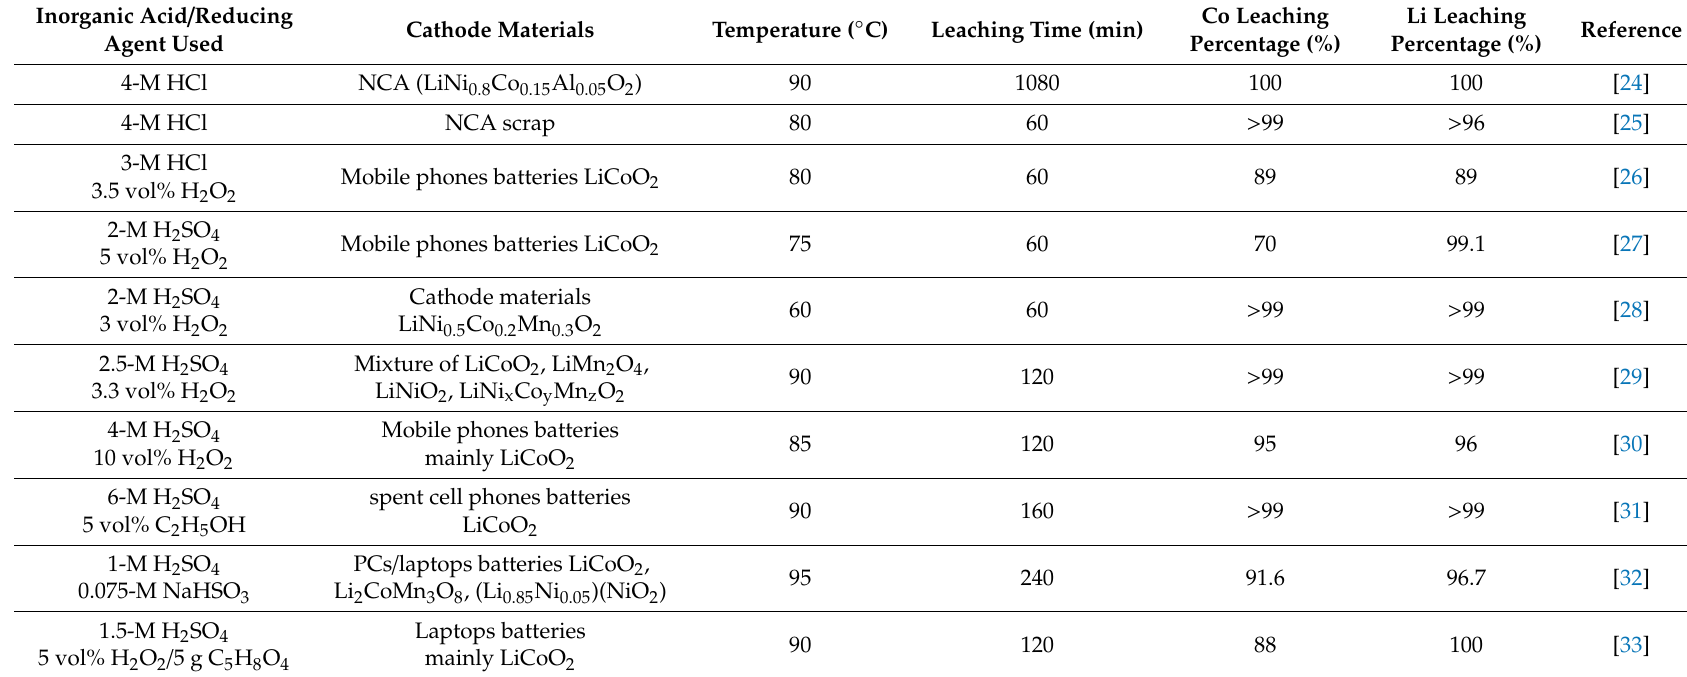
Table 2. Recent research for cathodic metals leaching by inorganic